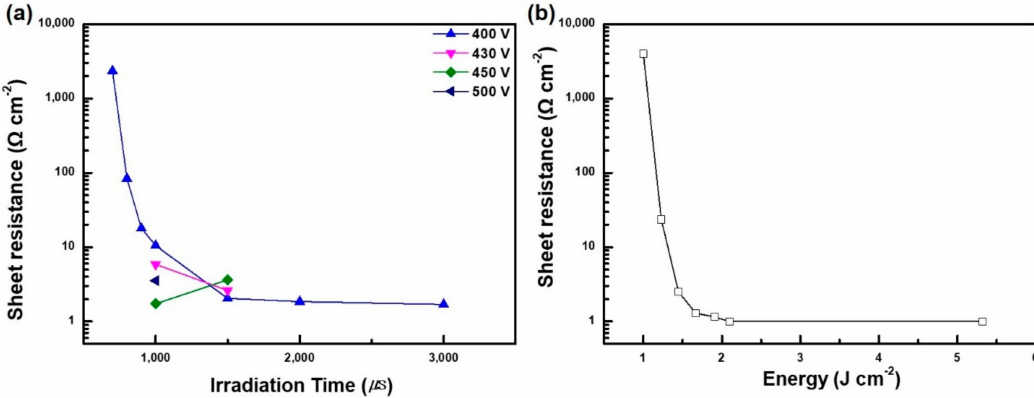
Figure 3. Electrical properties tests. ( a ) Sheet resistance at di ff erent applied voltage as a function of irradiation time. ( b ) Sheet resistance as a function of applied energy for threshold value.